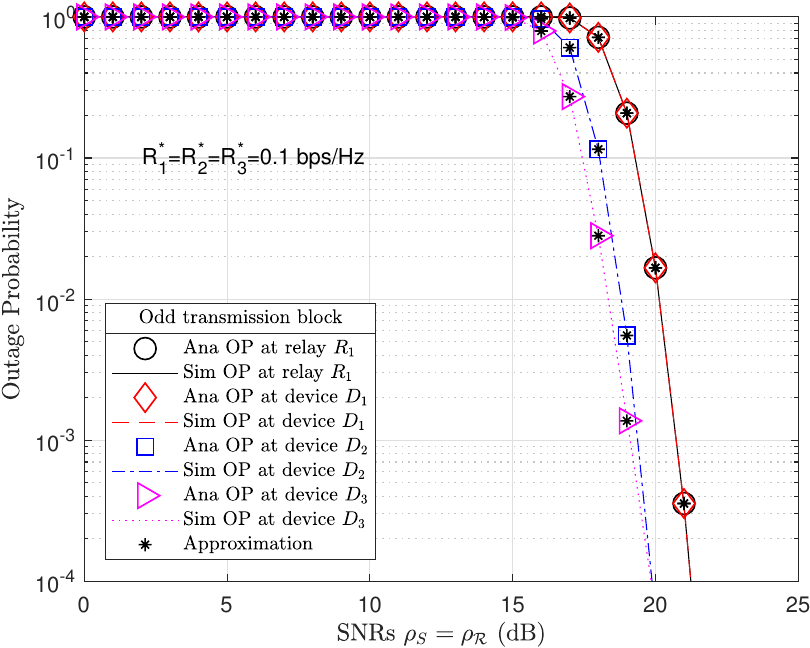
Figure 3. OP at relay R 1 and devices D n for n = { 1, . . . , N } in an odd transmission block, where the number of antennas equipped at the BS, relay R 1 and devices D n are A 0 = 4, A 1 = 4, and A 2 = 2, respectively, and the PS factor λ = 0.4.